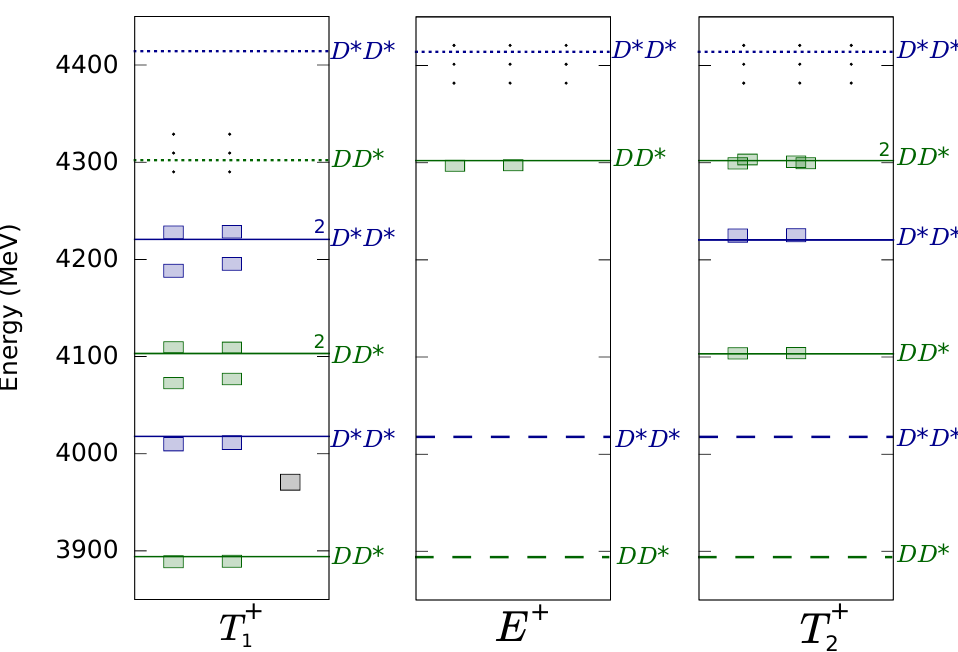
Figure 6 . As (cid:12)gure 5 but for the isospin-0 doubly-charmed sector with quark (cid:13)avour cc (cid:22) l (cid:22) l . Dashed lines indicate kinematic thresholds where a non-interacting level is not expected. Dotted lines indi- cate non-interacting meson-meson levels where the corresponding operators have not been included in the operator basis. Ellipses indicate that additional energy levels have been extracted in/above these regions but we have not plotted them as we have not included all relevant meson-meson operators in these energy